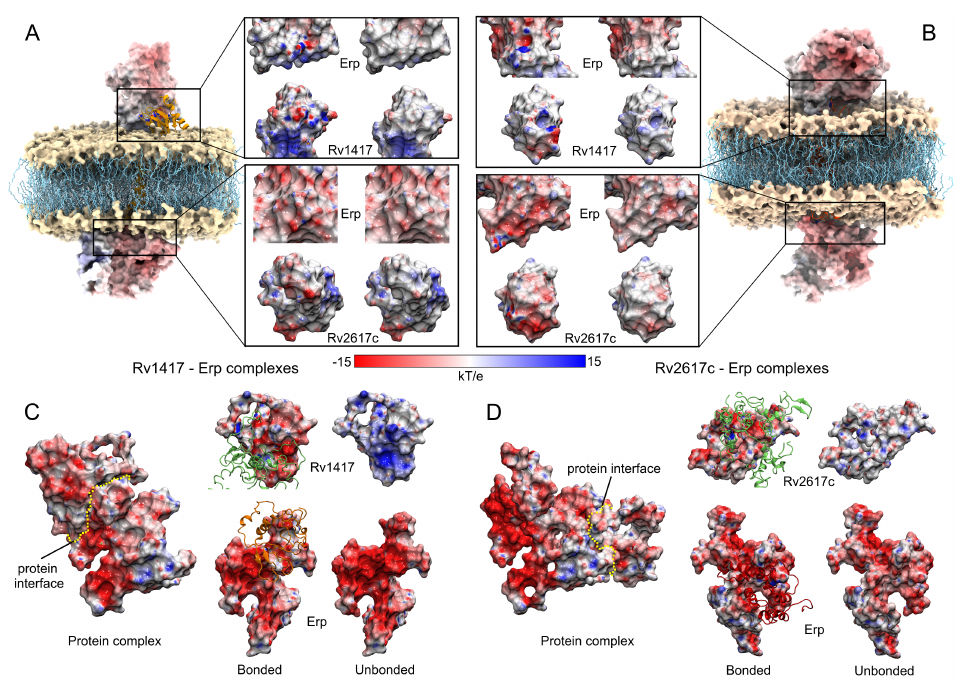
Figure 9. Electrostatic analysis of the best protein complexes obtained in the docking calculations. were analyzed in the cytoplasmic and extracellular regions. The insets in A and B show the contact surfaces between the Erp–RvPs structures. Within these insets, figures on the left represent the protein surfaces when they are attached, while figures on the right are the non-interacting structures. For unanchored complexes ( C , D ), the yellow dotted line represents the interface between the proteins. Contact surfaces are shown in the front view. For both membrane and unanchored systems, the same color scale was used. Blue, red, and white colors represent positively charged, negatively charged, and neutral surfaces,